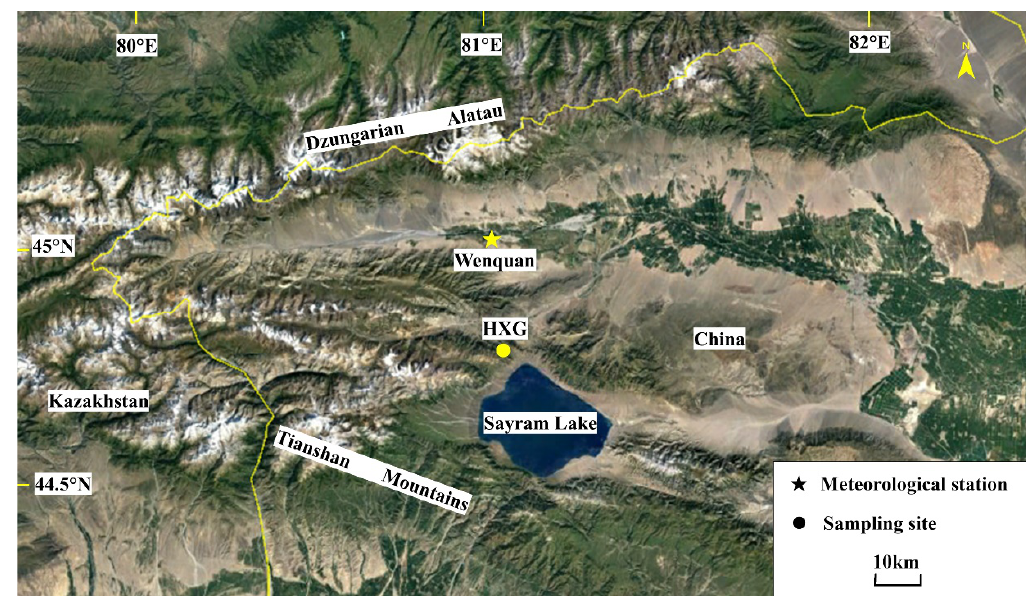
Figure 1. Map of tree-ring sample site and meteorological station information.